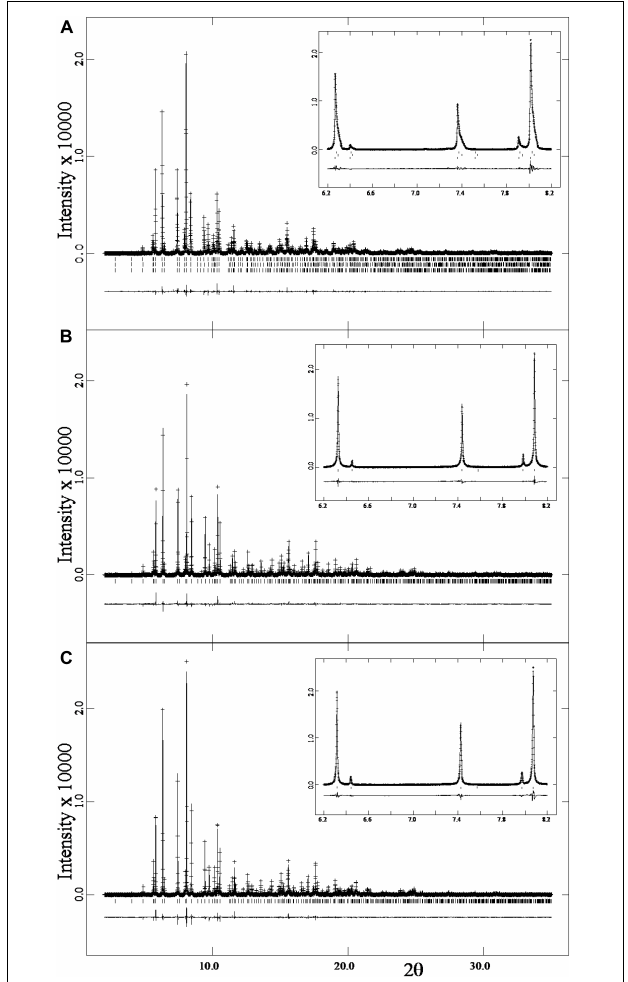
FIGURE 3 | HRPXRD traces for three nepheline samples: (A) sample 3, (B) sample 1, and (C) sample 2. Calculated (continuous) and observed (crosses) profiles are shown. The difference curve ( I obs – I calc ) is shown at the bottom. The short vertical lines indicate the allowed reflection positions. The inserts show expanded views of a small 2 θ range. No satellite reflections occur in these samples. The trace in (A) contains three different phases of nepheline, as shown more clearly on an expanded scale in Figure 4